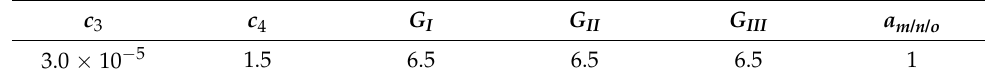
Figure 13. Direct cycle time. Table 4. Paris law parameters.